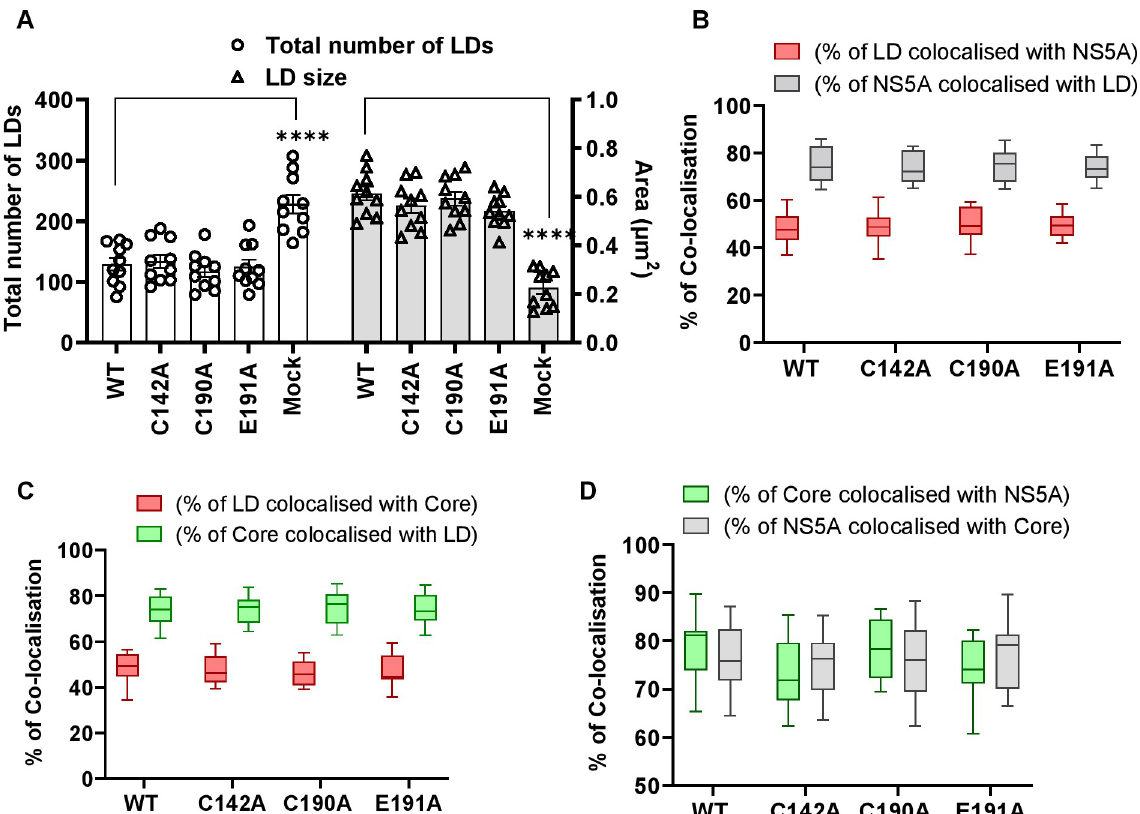
Fig 8. Quantification of LD size, abundance and co-localisation with NS5A and Core in PKR-silenced Huh7.5 cells. (A) LD numbers and size from Fig 7 were calculated using Analyze Particles module of Fiji. Mock: uninfected Huh7.5 cells. 10 cells were analysed for each sample. ( B) Quantification of percentage of LDs colocalizing with NS5A (red), and NS5A colocalized with LD (grey). ( C) Quantification of the percentage of LD colocalized with Core (red), and Core colocalized with LD (green). ( D ) Quantification of the percentage of Core colocalized with NS5A (green), and NS5A colocalized with Core (grey). Co-localisation was analyzed in 10 cells for each construct using Fiji. Significant differences from WT denoted by ���� (P <